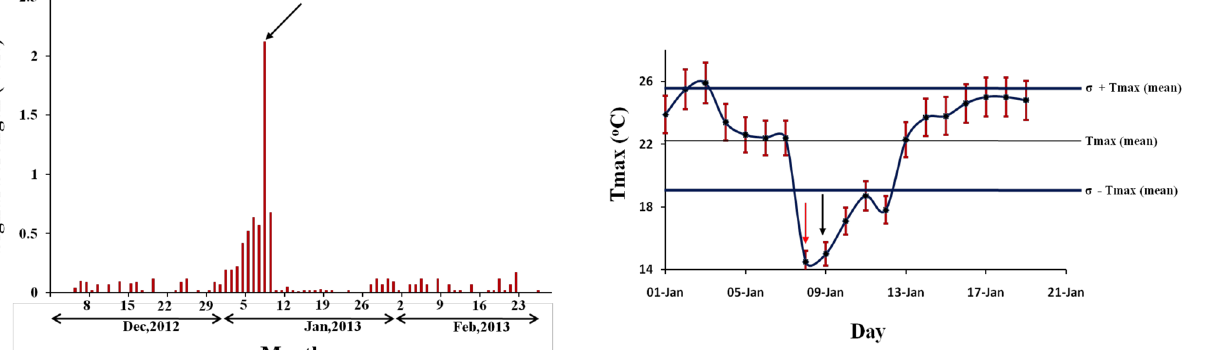
Figure 3. Signal strength (volts) received at GU, from the Chukha FM transmitter for the period December 2012 to February 2013. Note the sudden appearance of the signal from January 2 to Janu- ary 8. The arrow mark shows the day (January 8) when signal strength reaches its peak.